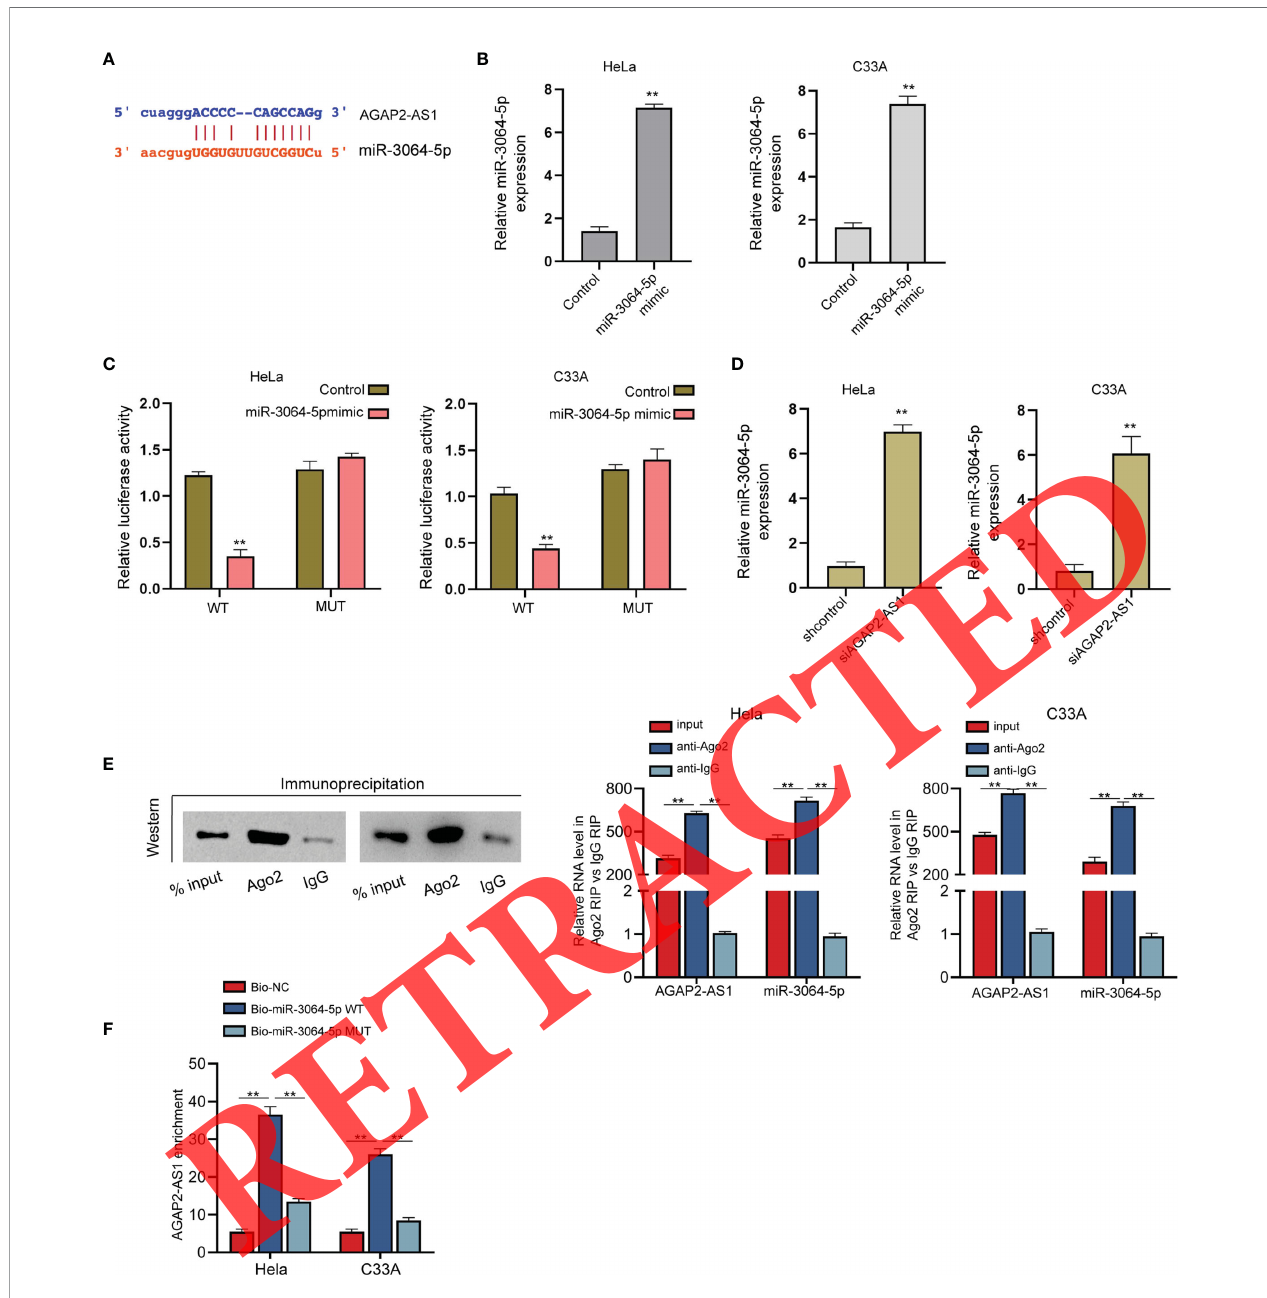
FIGURE 3 | AGAP2-AS1 interacts with miR-3064-5p. (A) The binding site between AGAP2-AS1 and miR-3064-5p was analyzed in ENCORI database. (B, C) The Hela and C33A cells were treated with miR-3064-5p mimic. The expression of miR-3064-5p was detected by qPCR (B) and the luciferase activity was measured by dual luciferase reporter assays (C) . (D) The Hela and C33A cells were transfected with AGAP2-AS1 siRNA, and the expression of miR-3064-5p was examined by qPCR. (E, F) Ago2 RIP (E) and RNA pulldown (F) assay were performed to identify AGAP2-AS1 directly combined with miR-3064-5p. mean ± SD, ** P < 0.01 vs Control or